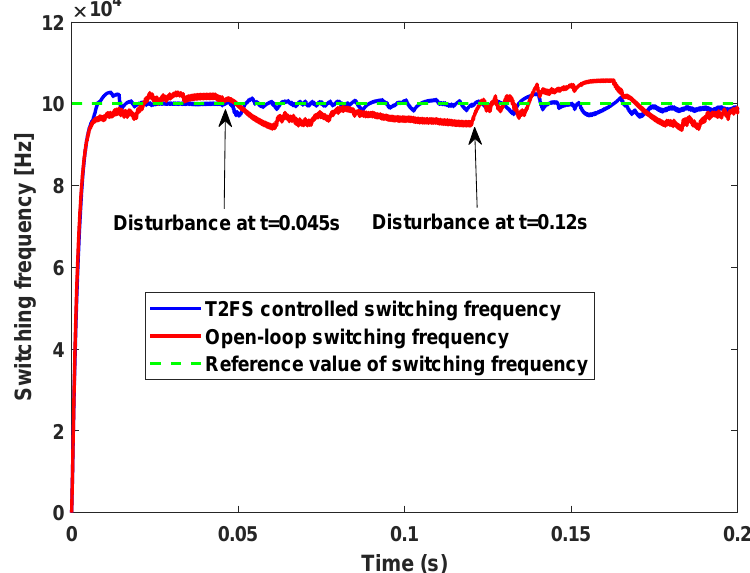
Figure 13. Transient response of switching frequency under load resistance step